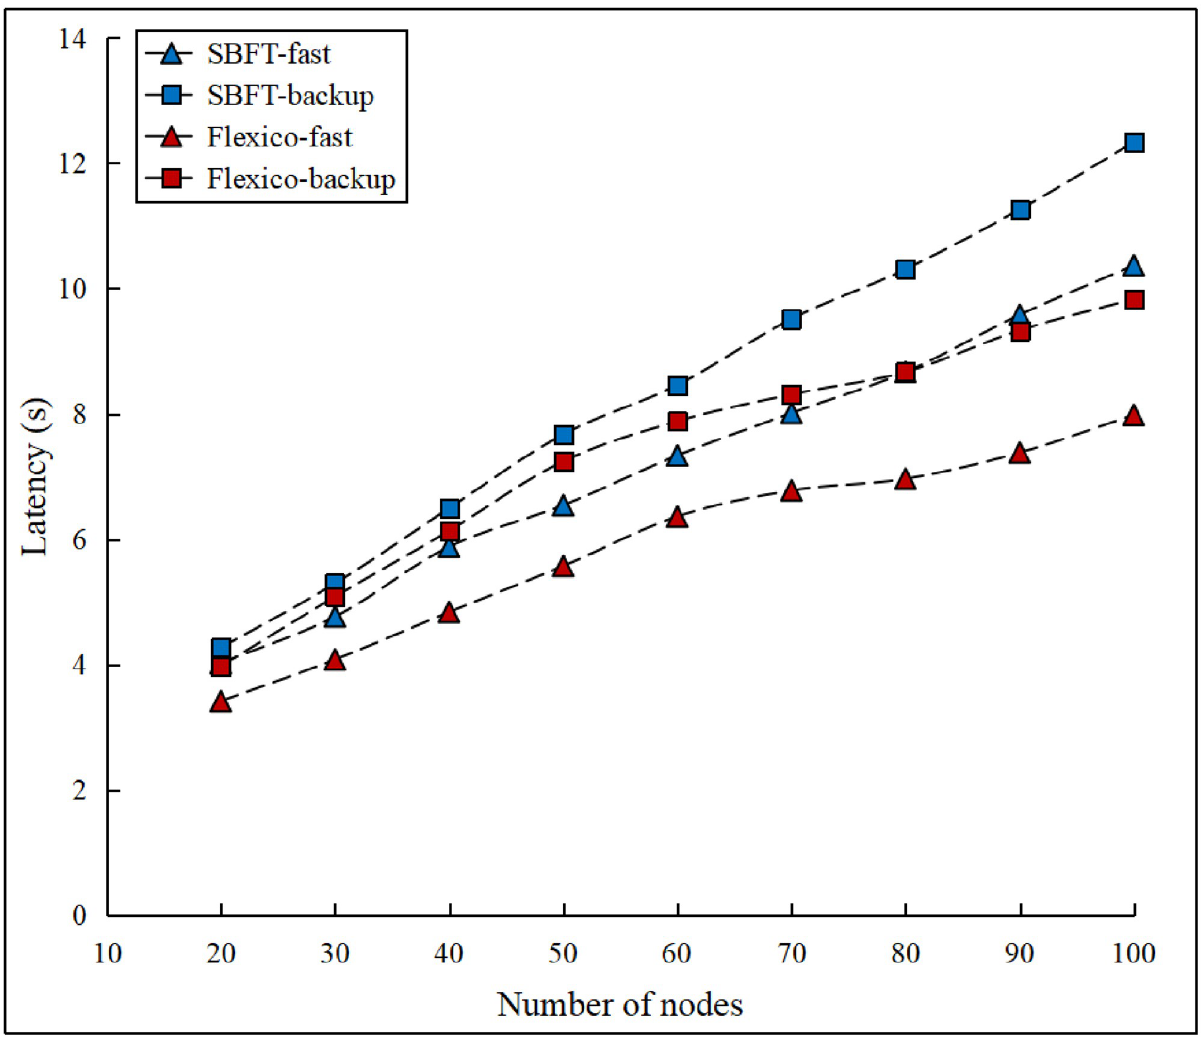
Fig 9. Dual-mode protocol latency